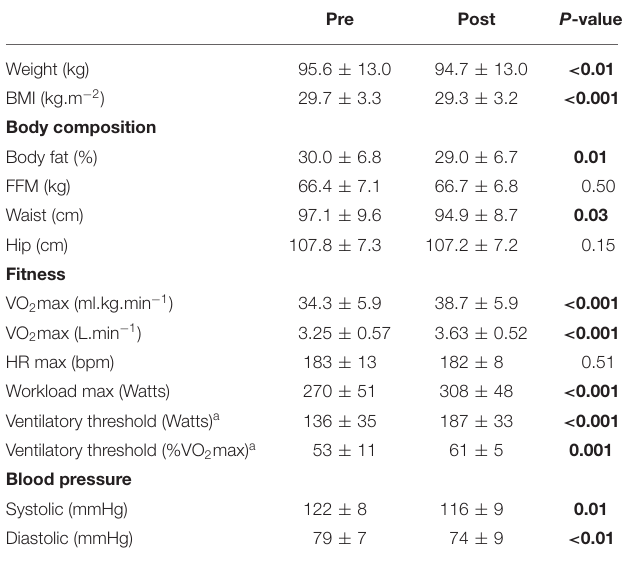
TABLE 1 | Participant anthropometric, body composition, cardiorespiratory fitness, and blood pressure characteristics pre- and post- 4-week exercise intervention ( n = 15).